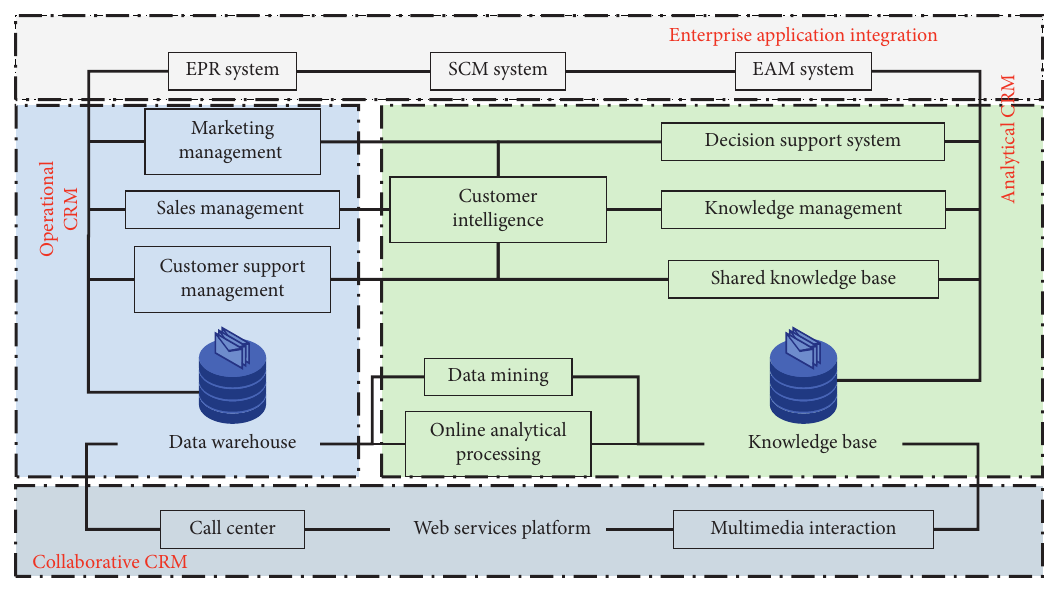
Figure 1: Data noise processing based on data